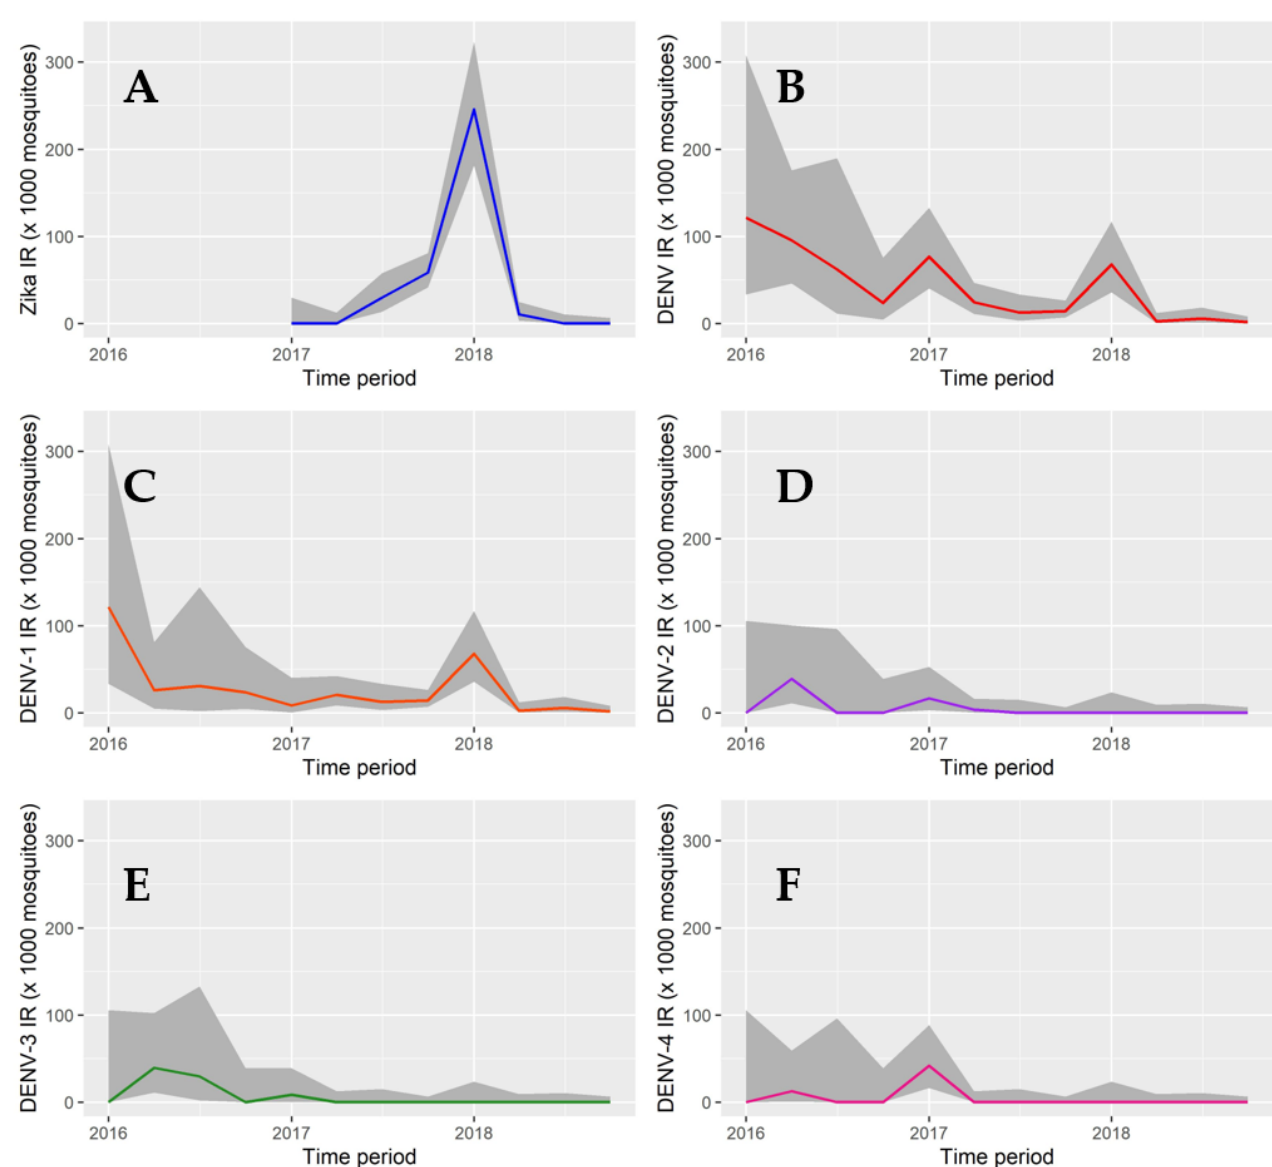
Figure 5. Arbovirus infection rates in mosquitoes captured in schools between 2016 and 2018. The 95% confidence interval is colored in gray. ( A ) Zika virus. ( B ) Dengue virus (all serotyped combined). ( C ) Dengue serotype 1 (DENV-1). ( D ) Dengue serotype 2 (DENV-2). ( E ) Dengue serotype 3 (DENV-3), and ( F ) Dengue serotype 4 (DENV-4). Table 6. CorrelationbetweenIRsand Aedes indicesfor Ae. aegypti, Ae. albopictus, andbothspeciescombined. Ae. aegypti Ae. albopictus Both